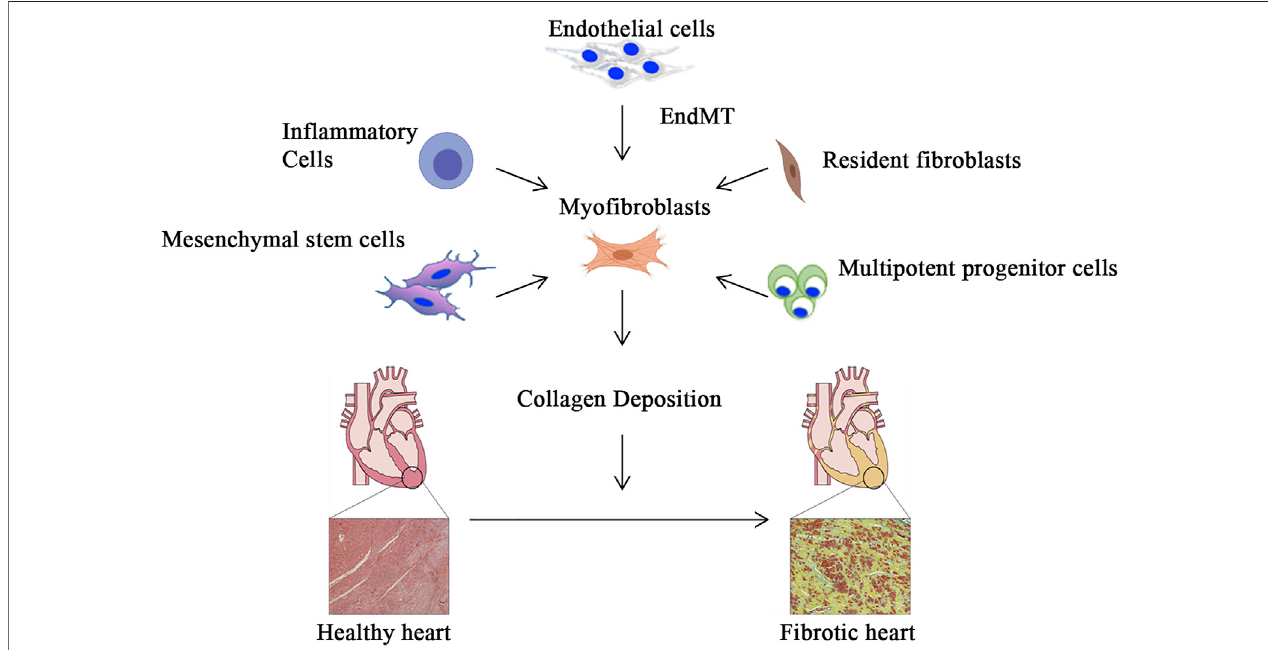
FIGURE2| Myo fi broblastactivationandmyocardial fi brosis.Inadditiontodifferentiationfromresident fi broblasts,myo fi broblastscanbederivedfromin fl ammatory cells, bone marrow-derived mesenchymal stem cells and pluripotent progenitor cells, and endothelial cells that undergo endothelial-mesenchymal transition. Subsequently, activated myo fi broblasts secrete extracellular matrix, which gradually leads to the development of myocardial fi brosis.